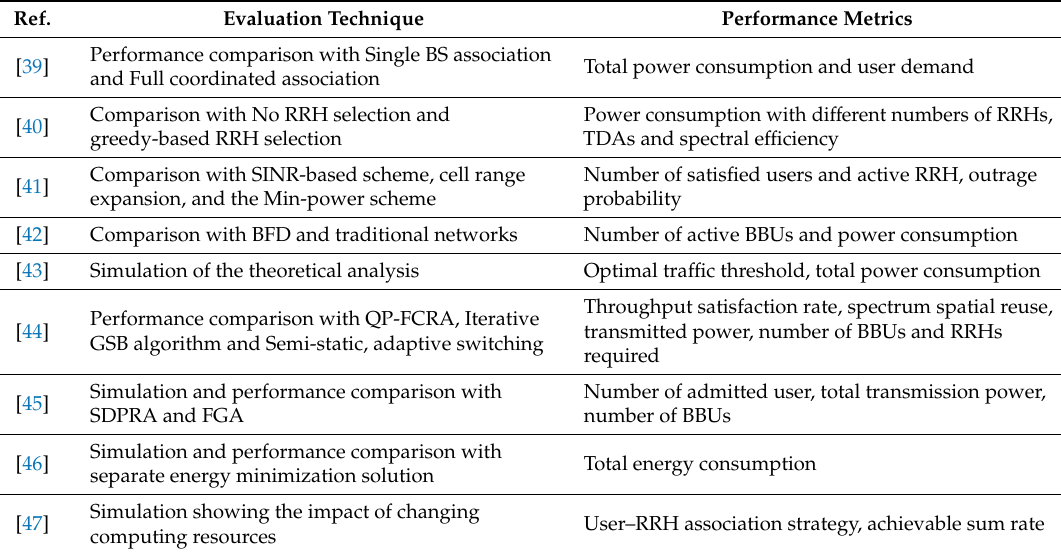
Table 3. Performance evaluation techniques and performance metrics used in radio resource management.